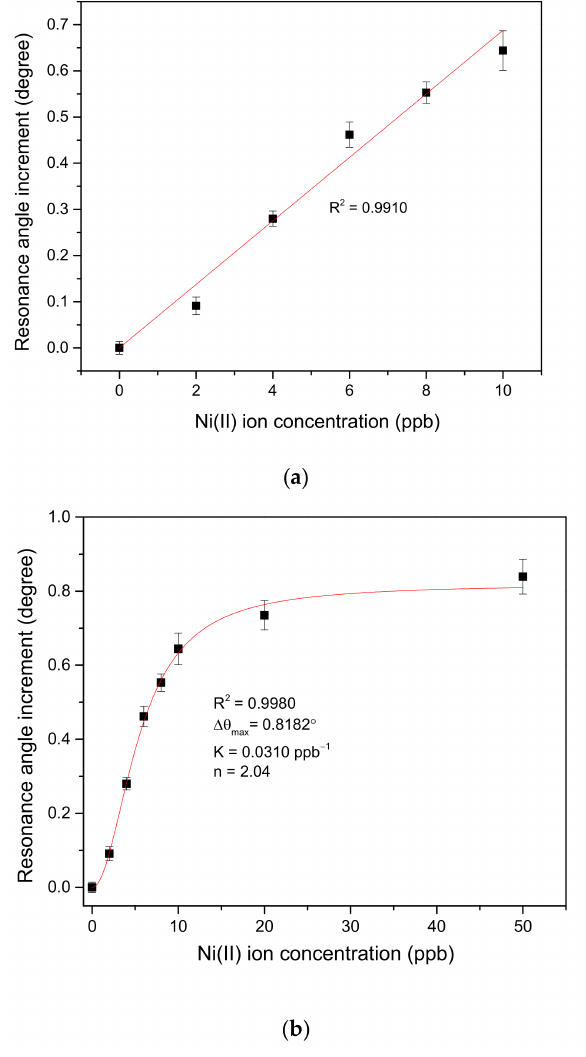
Figure 5. Plot of resonance angle increment with Ni(II) ion concentration for ( a ) sensitivity and ( b ) binding affinity